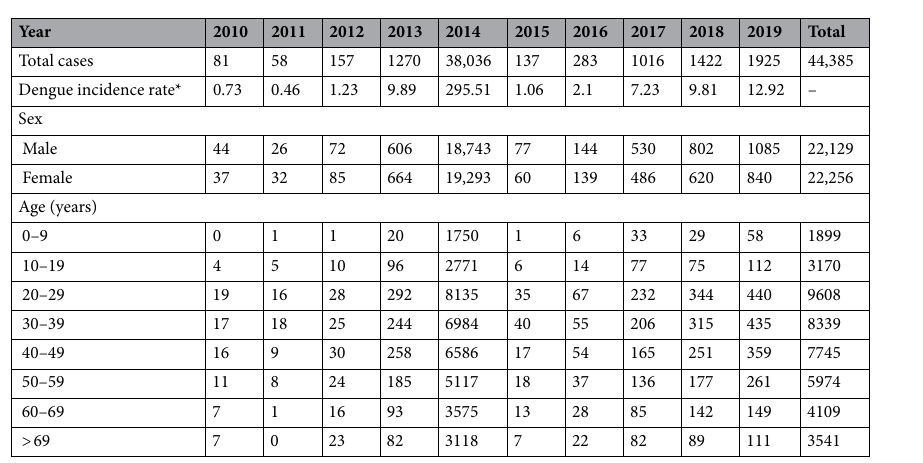
Table 1. Incidence of dengue in Guangzhou between 2010 and 2019, according to age and sex. *Dengue incidence rate per 100,000